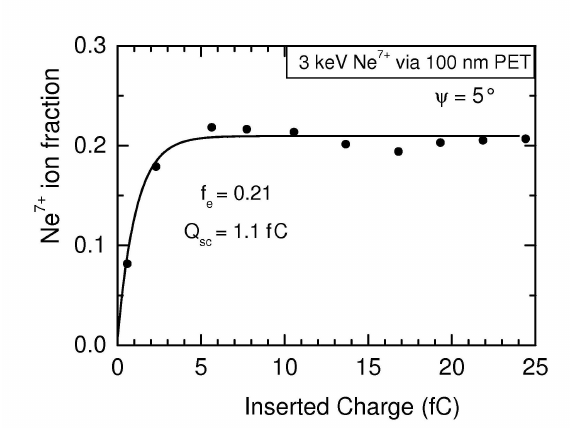
Figure 1. Fraction of 3-keV Ne 7 + ions transmitted through PET capillaries with the diameter of 100 nm. The points are experimental data fitted by Equation (3) where f e is the equilibrium value and Q sc is the characteristic charge. Data taken from Ref.